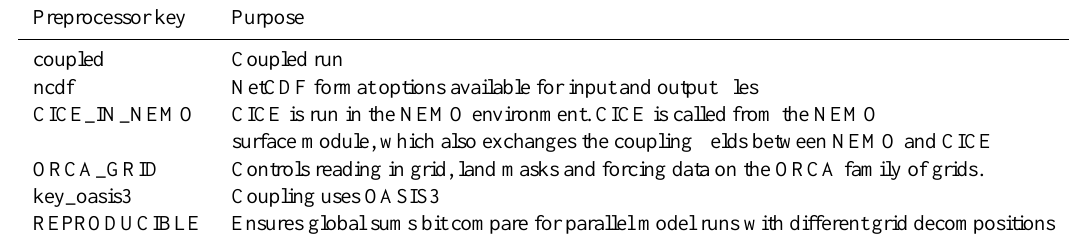
Table 2. The preprocessor keys used for CICE in GC2.0-GSI6.0. Preprocessor